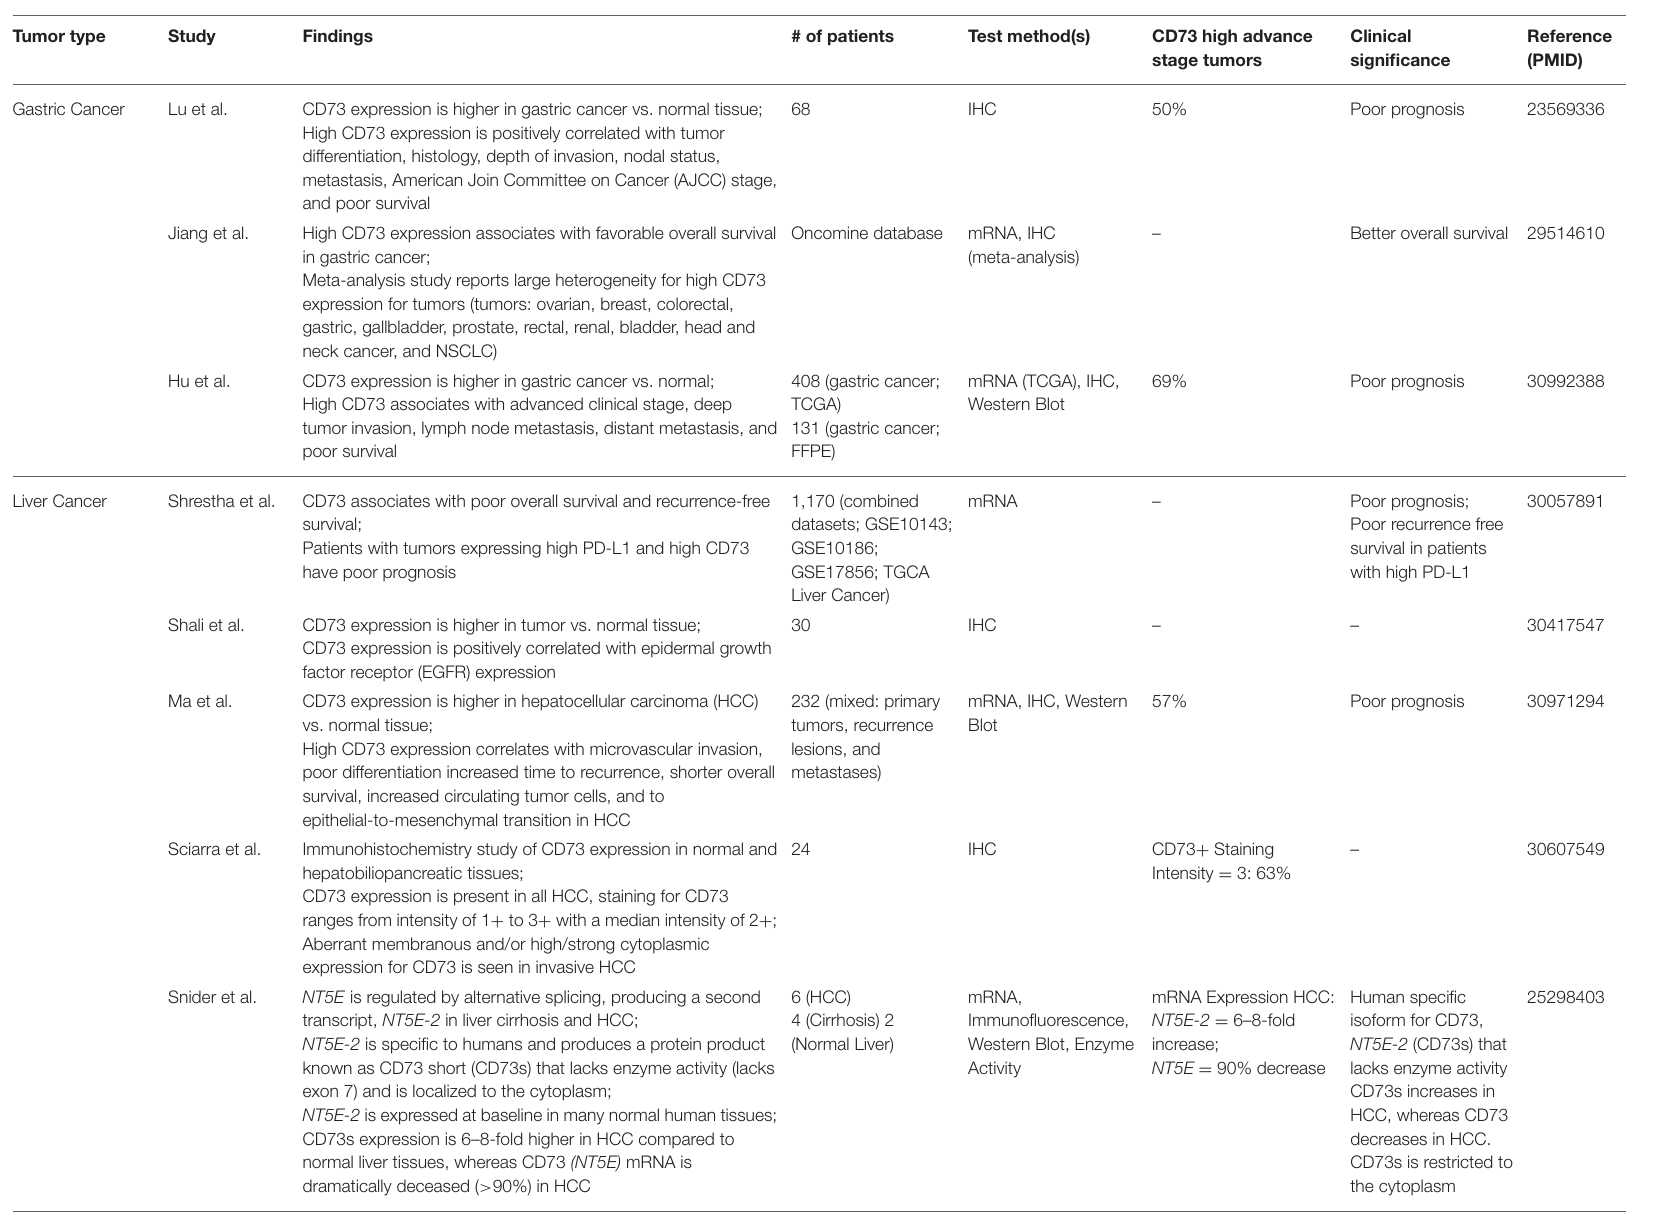
TABLE 2 | Summary of studies assessing CD73 expression in human GI